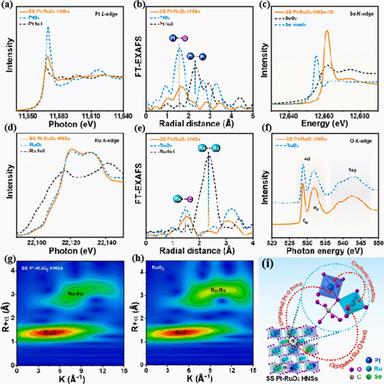
(a) Pt L3-edge XANES and (b) Pt L3-edge EXAFS spectra of SS Pt–RuO2 HNSs, PtO2, and Pt foil. (c) Se K-edge XANES spectra of SS Pt–RuO2 HNSs, SeO2, and Se mesh. (d) Ru K-edge XANES and (e) Ru K-edge EXAFS spectra of SS Pt–RuO2 HNSs, commercial RuO2, and Ru foil. (f) O K-edge XANES spectra of SS Pt–RuO2 HNSs and commercial RuO2. Wavelet transform of Ru K-edge EXAFS data of (g) SS Pt–RuO2 HNSs and (h) Commercial RuO2. (i) Structural illustration of SS Pt–RuO2 HNSs.